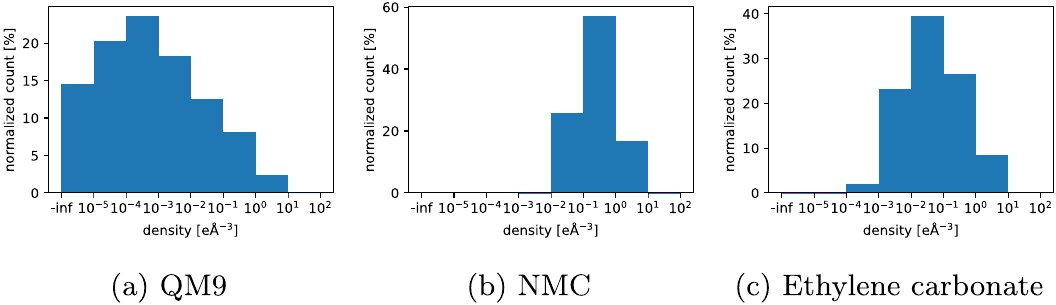
Fig. 10 Normalized histograms with logarithmic bins for the data examples of the three electron density datasets. QM9 ( a ) LIB Cathode ( b ) and Ethylene Carbonate ( c ). The histograms use logarithmic bins and show the number of data examples that fall into each bin as a percentage of the total number of